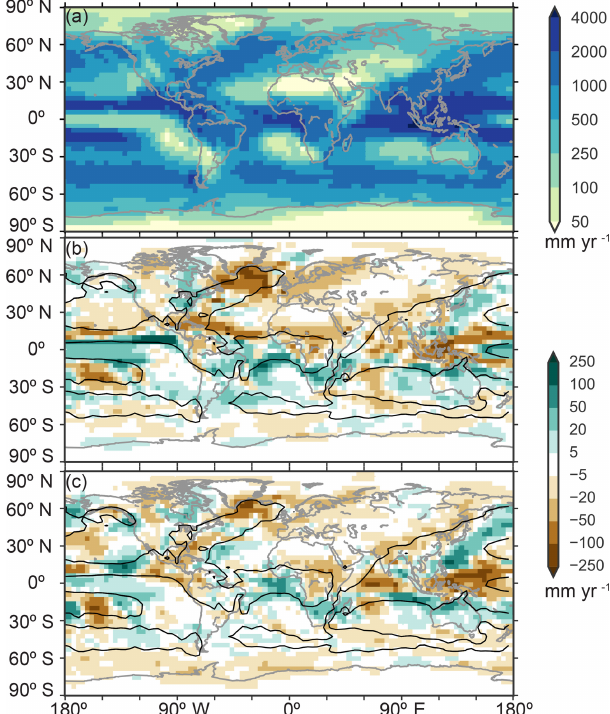
Figure 10. (a) Annual mean precipitation in the pre-surge phase and precipitation changes in (b) the surge phase and (c) the post- surge phase with pre-surge 1myr − 1 isoline overlain to allow for an easier identification of the ITCZ. For a definition of the phases see Fig. 1 and Sect.